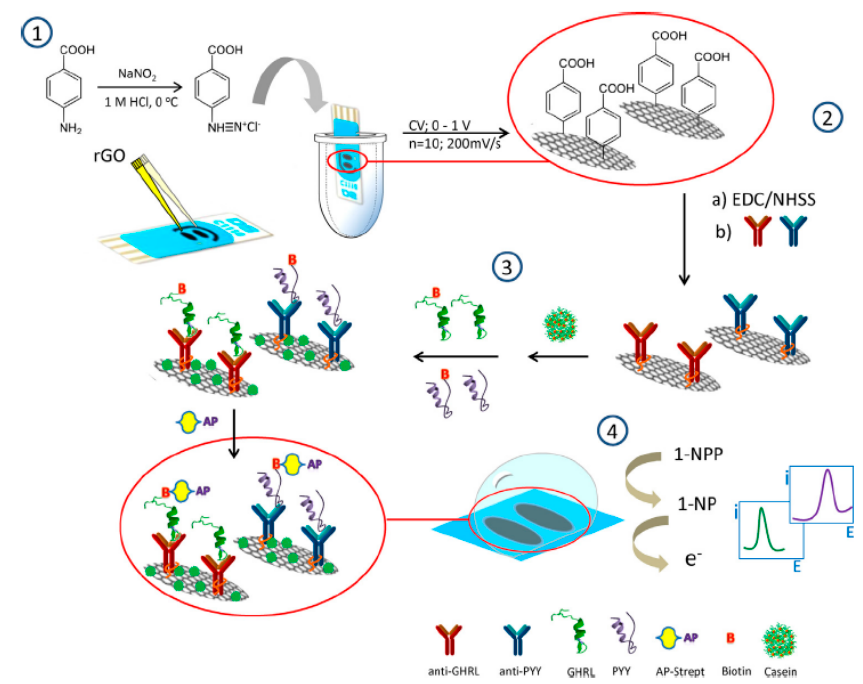
Figure 4. Scheme of the different steps involved in the preparation and functioning of the dual GHRL and PYY immunosensors. Reprinted from Ref. [30] with permission.